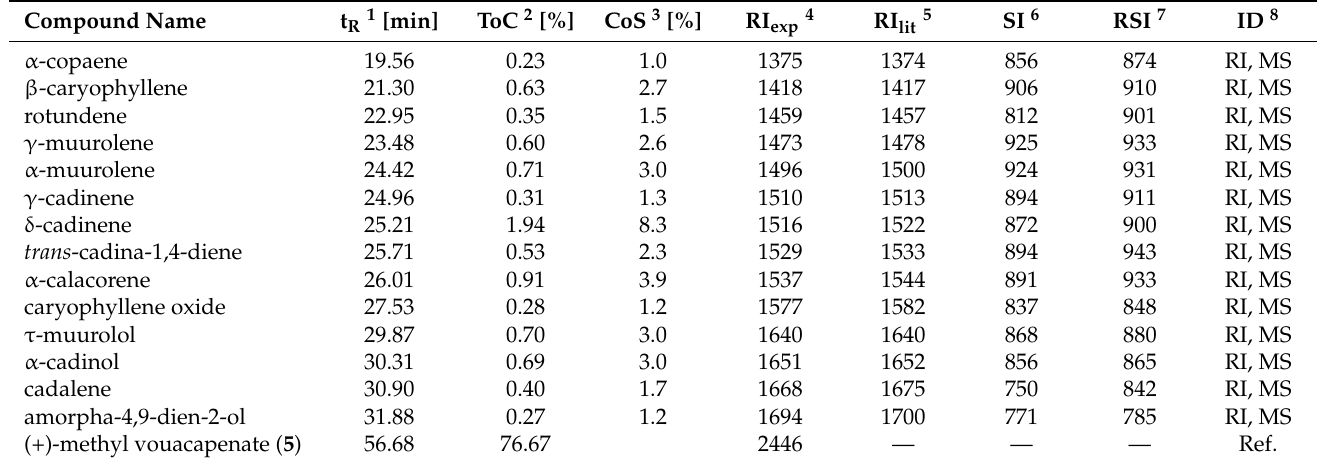
Table 1. Composition of the essential oil identified by GC-MS analysis and retention indices. (+)- methyl vouacapenate ( 5 ) was retrospectively identified by comparison with the isolated